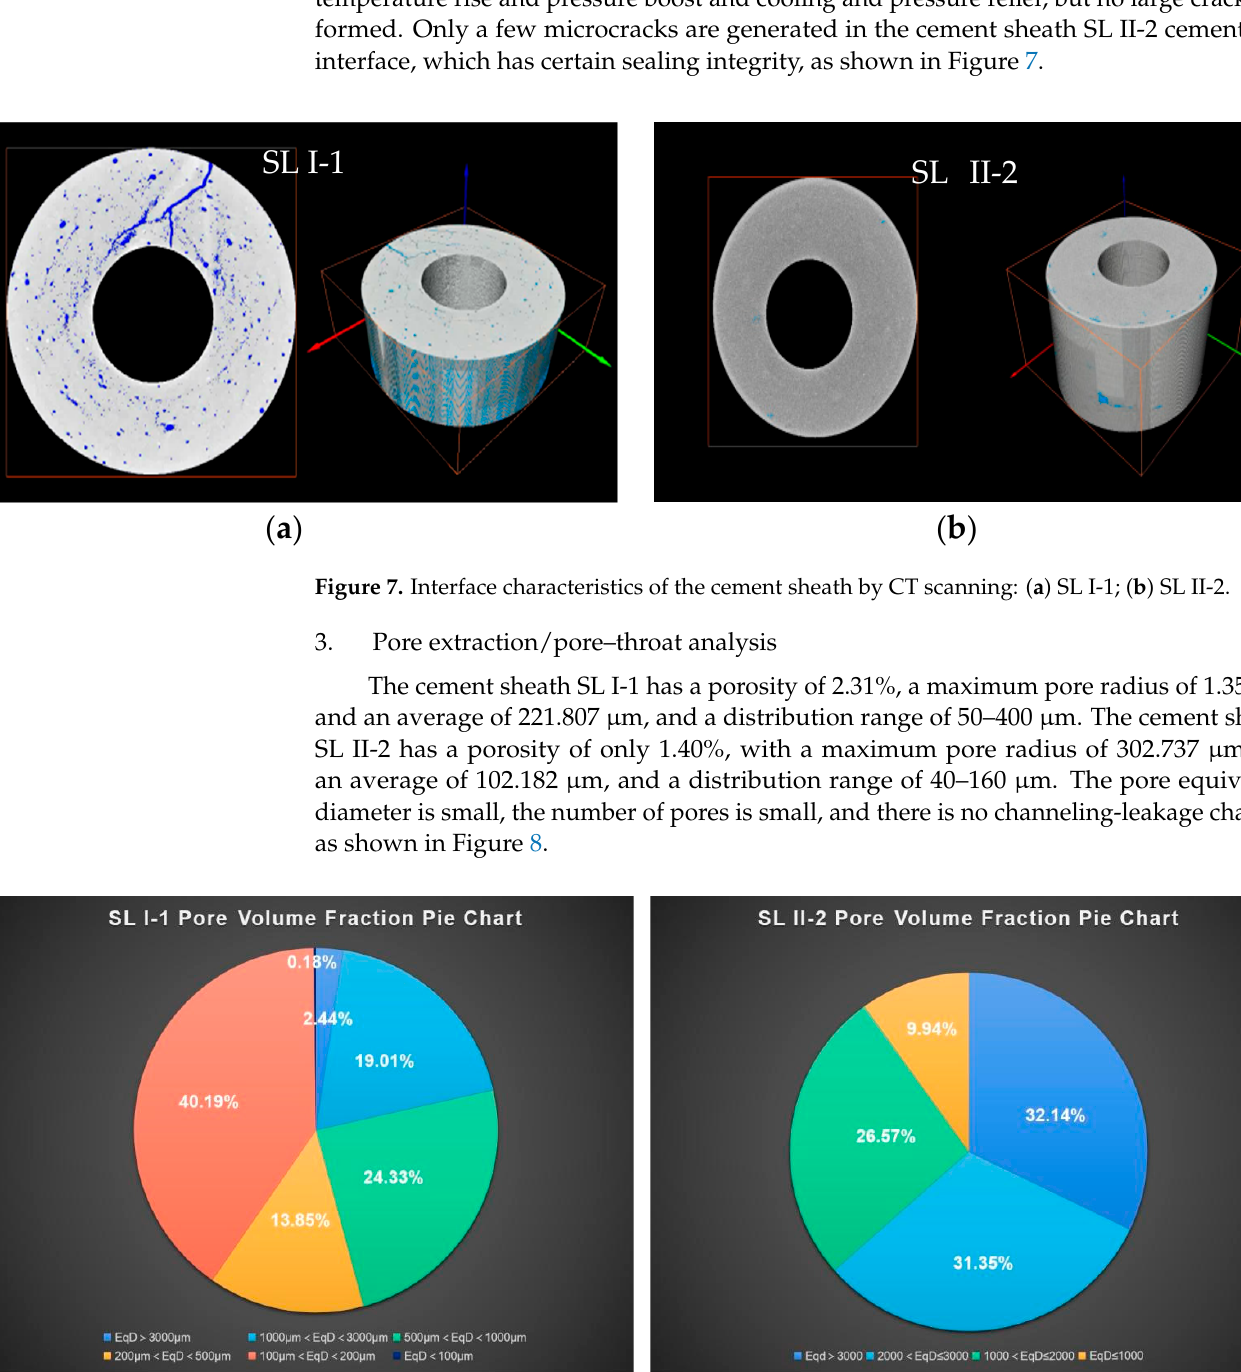
( b ) Figure 9. SEM micromorphology analysis of crack distribution characteristics: ( a ) SL I-1; ( b ) SL II-2. In conclusion, there are a large number of circular deformation points about 100 μ m in size in SL I-1, which firstly undergo elastic deformation, crack source nucleation, brittle fracture, and rapid propagation, showing a large number of large-size, penetrating, and irregular propagation cracks, which significantly affect the sealing ability of cement sheath SL I-1. The result is complete channeling between the cementing I interface, the body, and the cementing II interface, resulting in loss of seal integrity. Although the ce-